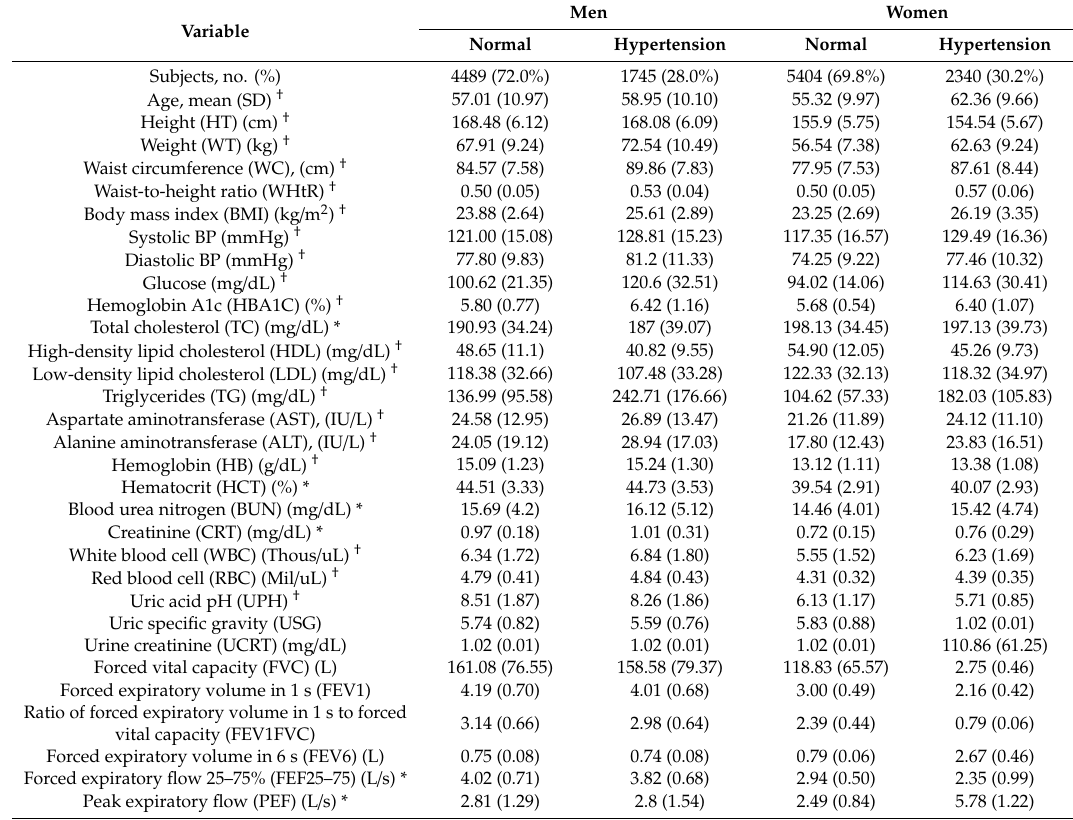
Table 2. Primary characteristics of all factors analyzed for metabolic